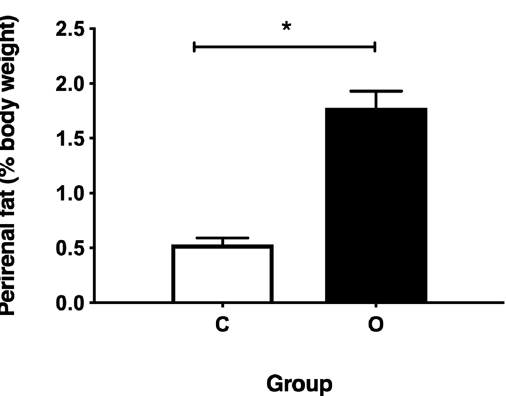
Figure 3. Maternal perirenal adiposity at the end of lactation. Values are for mean and SEM. Animals were fed either a control diet (C, n 12) or a cafeteria diet (O, n 10). Some animals were excluded from the analysis due to assessment of extreme outliers or data missing. * Effect of maternal diet on maternal perirenal adiposity using an independent samples T-test ( P <